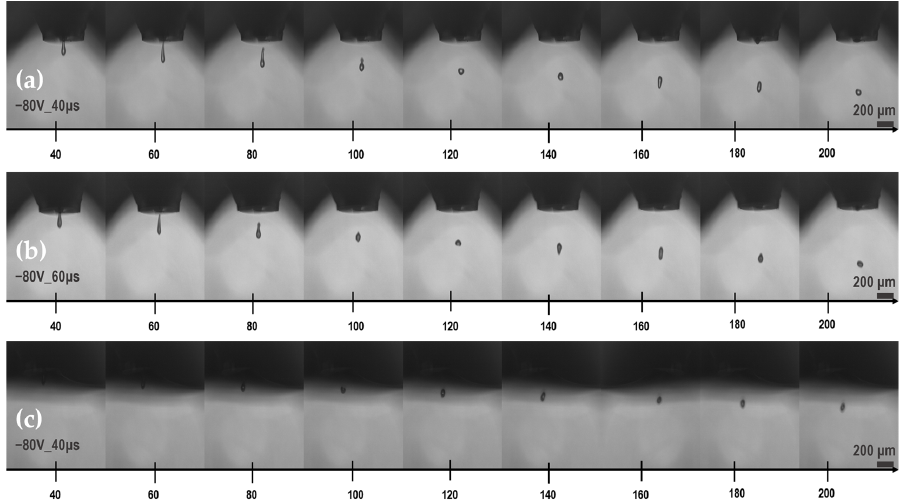
Figure 2. Droplet formation of f –rGO ink: ( a ) 2.5 wt% ( − 80 V/40 μ s); ( b ) 5 wt% ( − 80 V/60 μ s); ( c ) 10 wt% ( − 80 V/40 μ s).